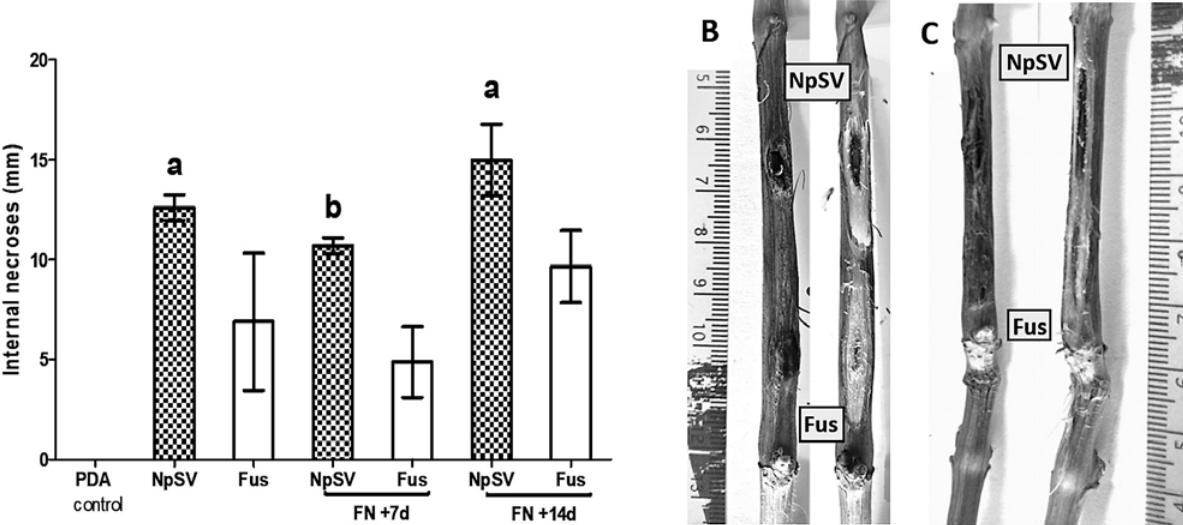
Figure 5. In A, mean lesion lengths (± SE) on rooted grapevine cv. Mourvèdre plants after inoculation with N. parvum strain NpSV and F. proliferatum strain Fus, at 60 dpi for single (NpSV, Fus) or dual inoculations ( carried out in the greenhouse. Differences among the means were evaluated by the Mann-Whitney non-parametric test. Bars accompanied by the same letter are not statistically significant different ( P ≤ 0.05). In B and C, external and internal lesions produced by Fus and NpSV in FN+7d and in FN+14d co-inoculated